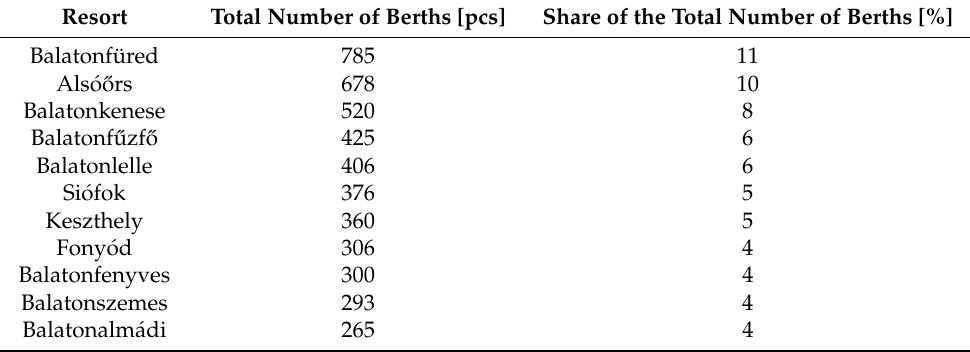
Figure 5. The numbers of permanent and visitors’ berths in the sailing marinas of the resorts at Lake Balaton, own results. Table 2. The 10 most significant resorts of Lake Balaton in terms of berths for sailboats, own